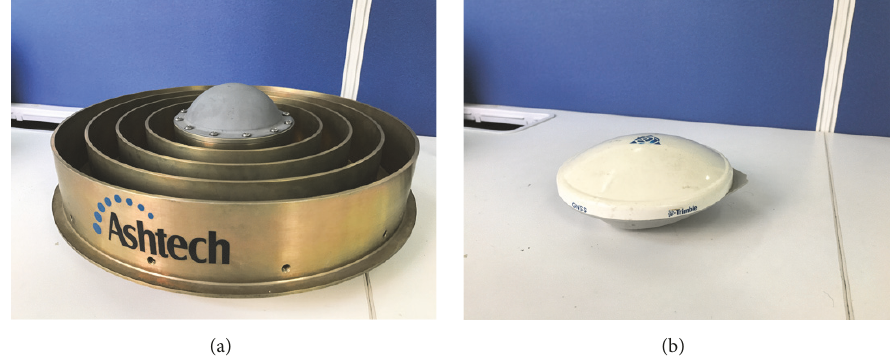
Figure 6: This photo is the two antennas used in the test. The left one is a chocking ring antenna designed and manufactured by Ashtech. The right one is a Trimble ZEPHYR (cid:2) -Model 2